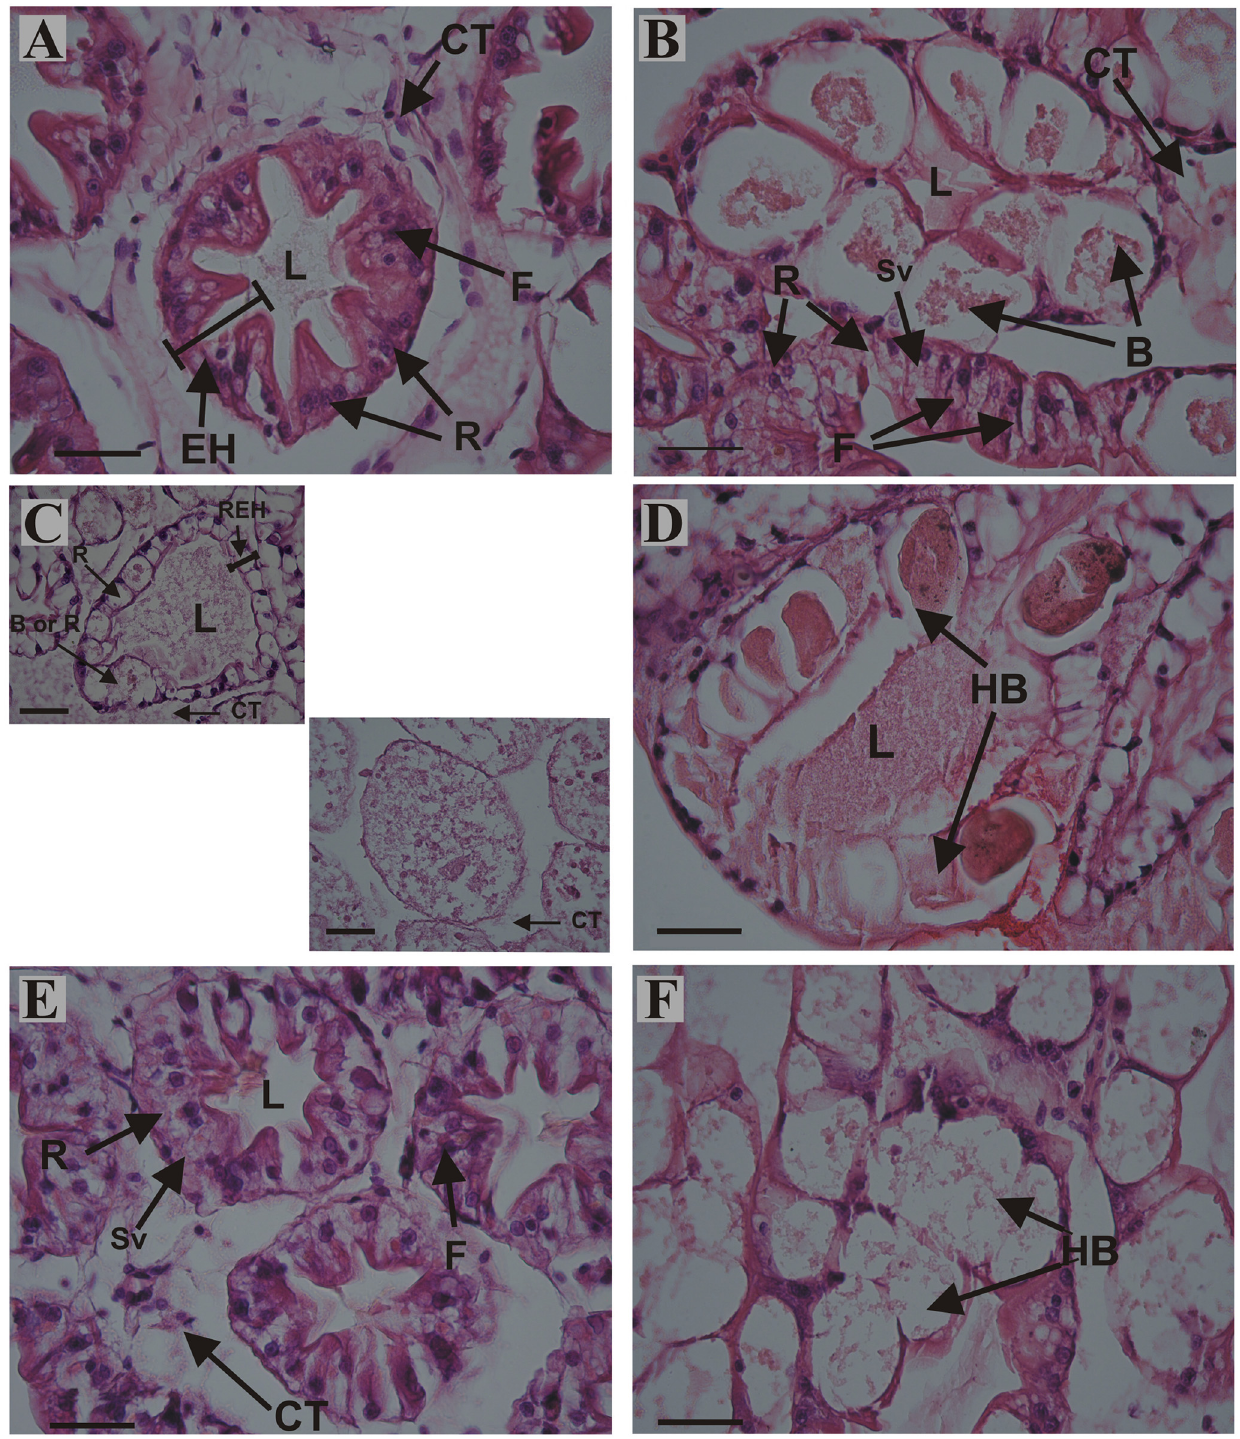
Fig 7. Detail of histological sections of the midgut gland from juveniles of Cherax quadricarinatus continuously fed (A, B), abnormalities after long-term starvation (C, D), and abnormalities after long-term starvation and posterior feeding (E, F). (A-F): cross sections of the tubules. (A) and (B): midgut gland structure, connective tissue (CT), epithelial height (EH), F cell, B cell and R cell with small vacuoles (Sv) of fed animals was preserved. (C): undifferentiated epithelium, R cells without small vacuoles, scarce differentiation between B and R cells, partial disorganization of connective tissue (CT), and reduction in epithelial height (REH). (D): hypertrophy of B cells (HB). (E): R cells with some small vacuoles (Sv), partial disorganization of connective tissue (CT), and reduction in the number of F cells per tubule. (F): hypertrophy of B cells (HB). Scale bars: 50 μ m. B: B cell; L: lumen of the tubule; R: R cell. doi:10.1371/journal.pone.0150854.g007 PLOS ONE | DOI:10.1371/journal.pone.0150854 March 28,